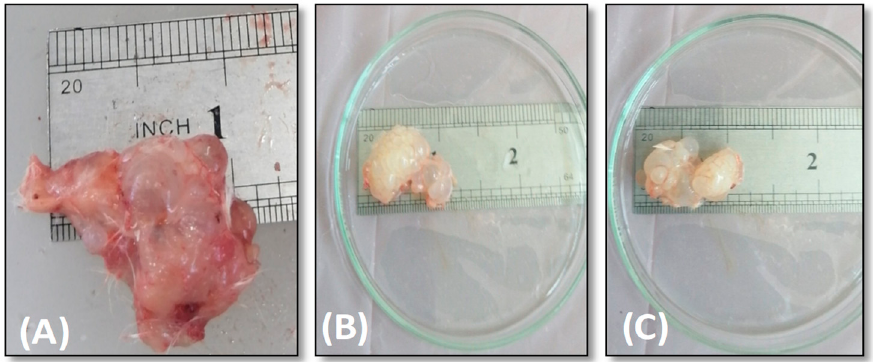
Figure 7. Cysts’ size isolated from the infected mice; ( A ) control untreated; ( B , C ) treated mice.